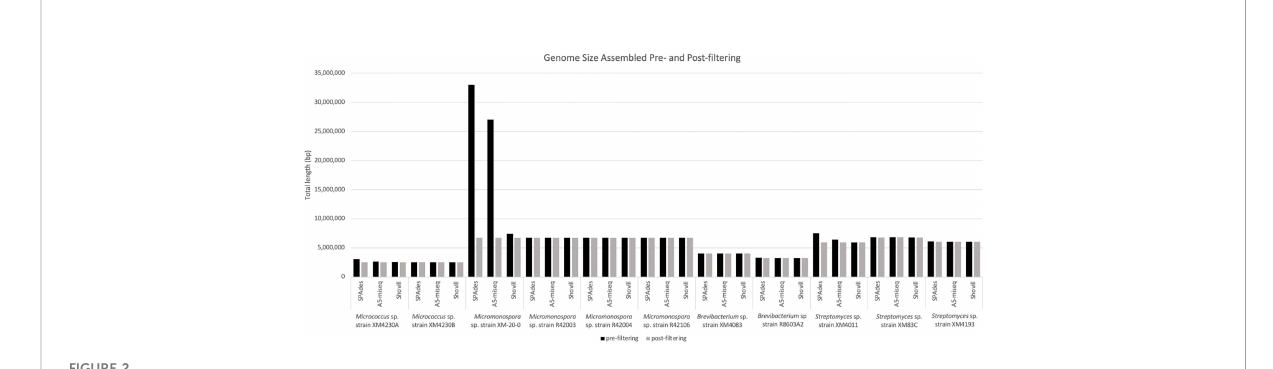
FIGURE 2 Total genome size calculated pre- and post- fi ltering for contamination and spillover.